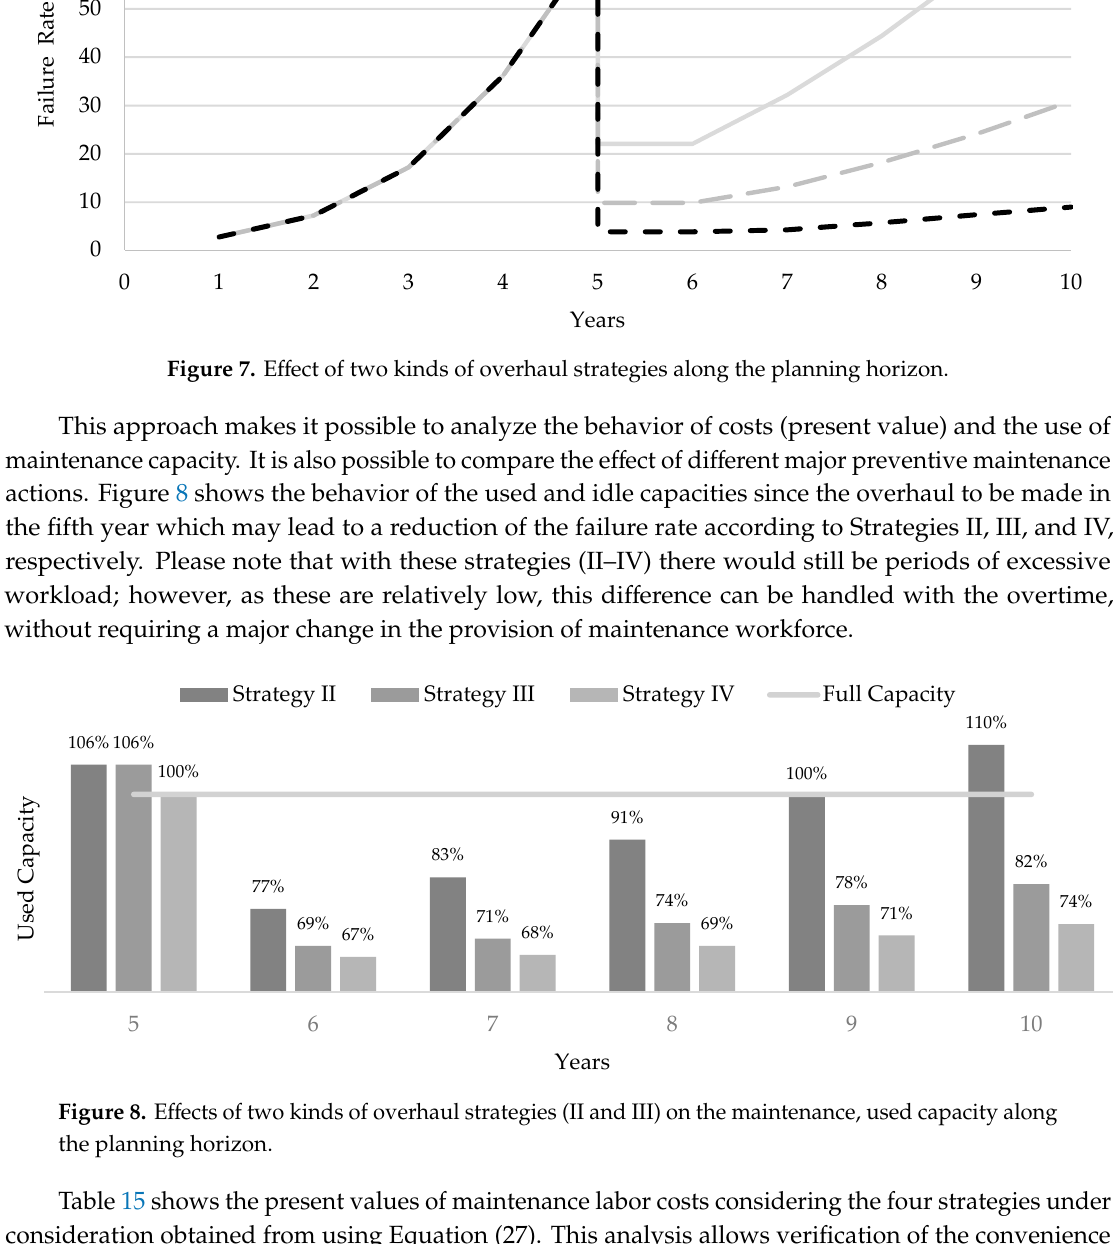
Table 15. Present values of maintenance labor costs considering the three maintenance strategies.